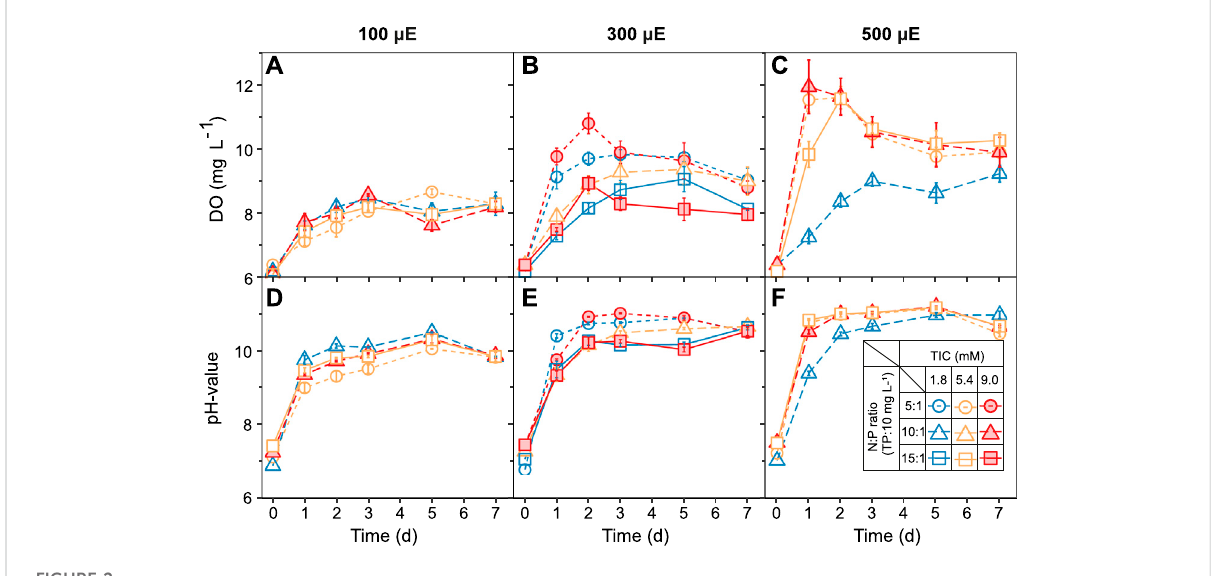
FIGURE 2 Algal turf scrubber (ATS) bio fi lms established a stable medium chemistry under all treatments within 3 days. Increasing light intensities to (A,D) 100, (B,E) 300, and (C,F) 500 μ mol photons m − 2 s − 1 elevated the dissolved oxygen and pH values, respectively. Data are presented as mean